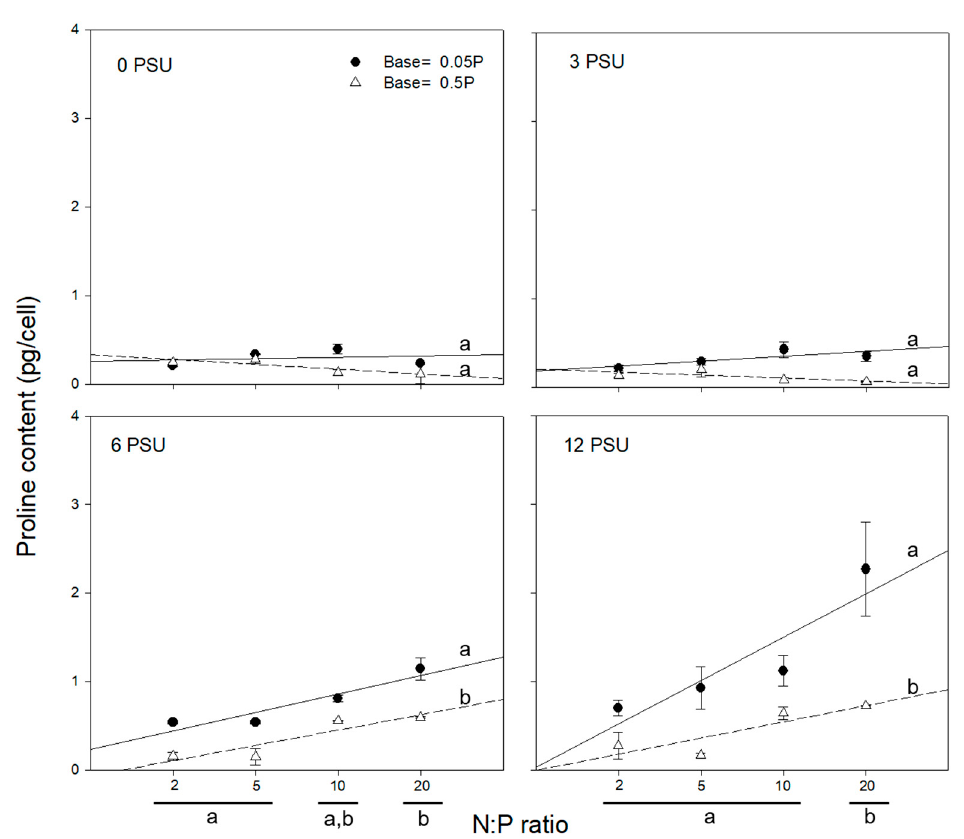
Figure 4. Variation in cellular proline content in S. quadricauda with increasing N:P ratio at fixed P concentrations (0.05 and 0.5 mgP/L) under salinity levels of 0, 3, 6, and 12 psu. N concentration differs for the same N:P ratio because P concentration was fixed. Experimental conditions are presented in Table 1 (Exp. 2 and 3). Data are presented as averages with standard deviations (bars). Lower case letters on the right side and bottom indicate significant differences ( p < 0.05).